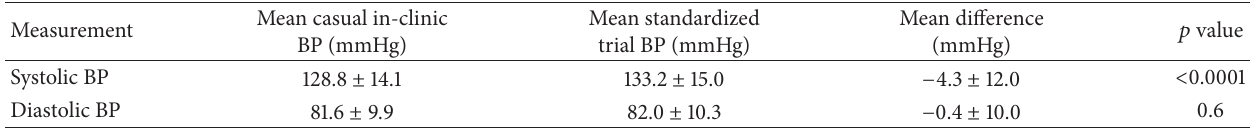
Table 2: Blood pressure